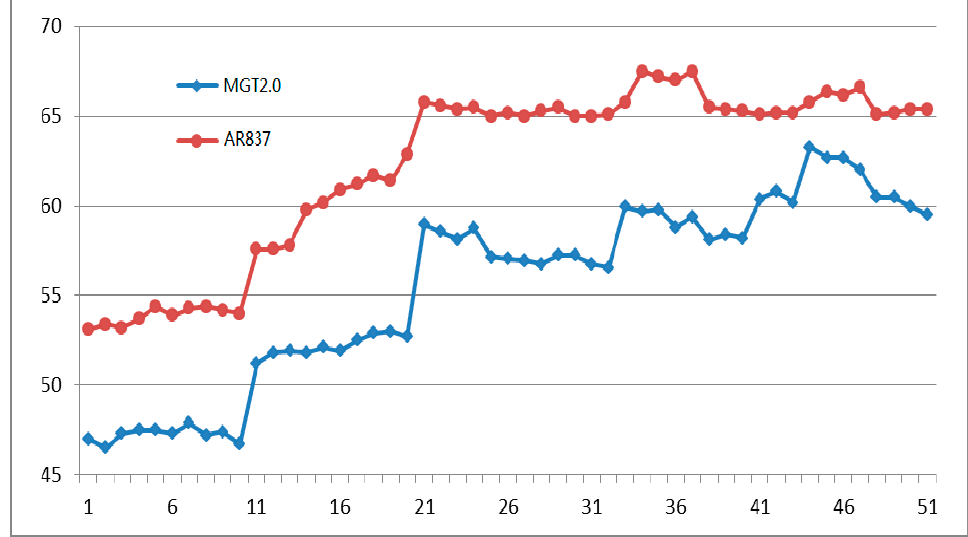
Figure 12. FIfty air humidity (%RH) experimental results by MGT2.0 (marked by blue line) and AR837 (marked by red line).